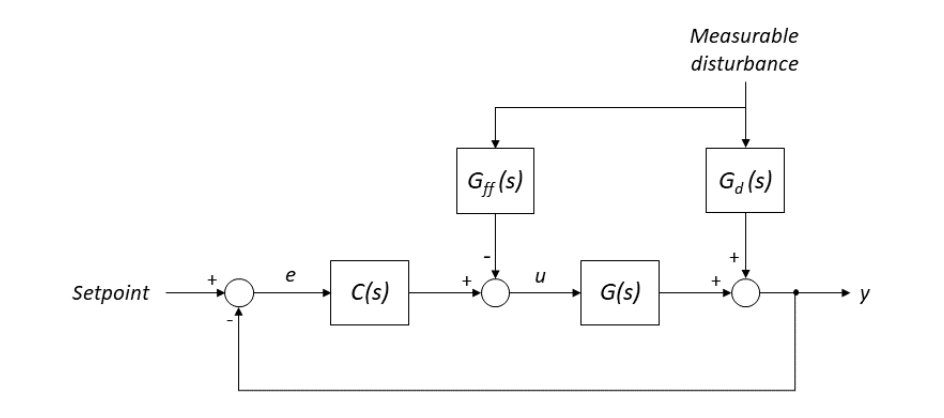
Figure 5. Simple feedforward control scheme, where C ( s ) is the feedback controller, G ( s ) is the process transfer function, G f f ( s ) is the feedforward compensator, and G d ( s ) is the transfer function modelling the effect of the measurable disturbance on the output of the